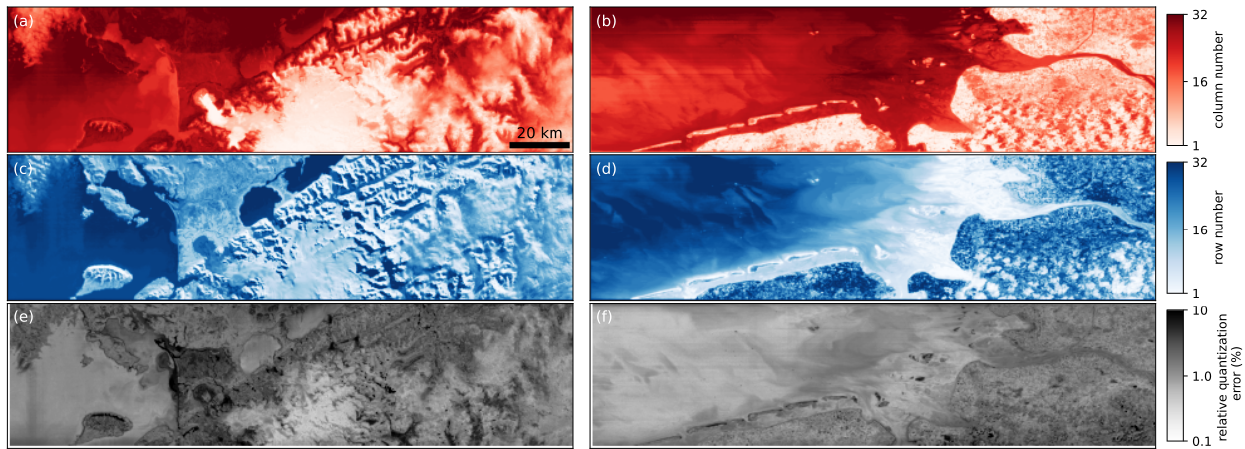
Figure 10. The HICO Lake Erie scene clustered according to the 32 ( left ) or the SOM calculated on itself ( right ), according to the ( a , b ) column number and ( c , d ) row number. ( e , f ) the relative quantization error.